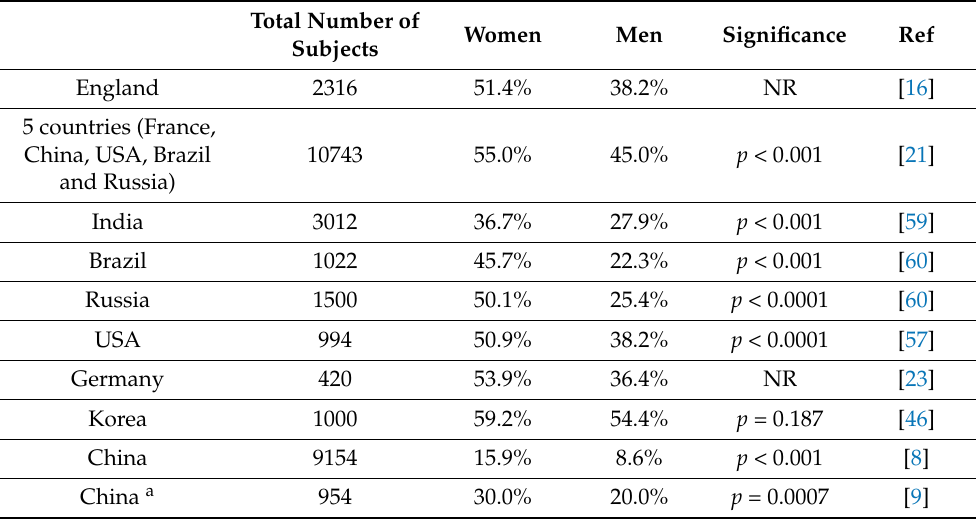
Table 4. Meta-analysis of gender differences in perceptions of